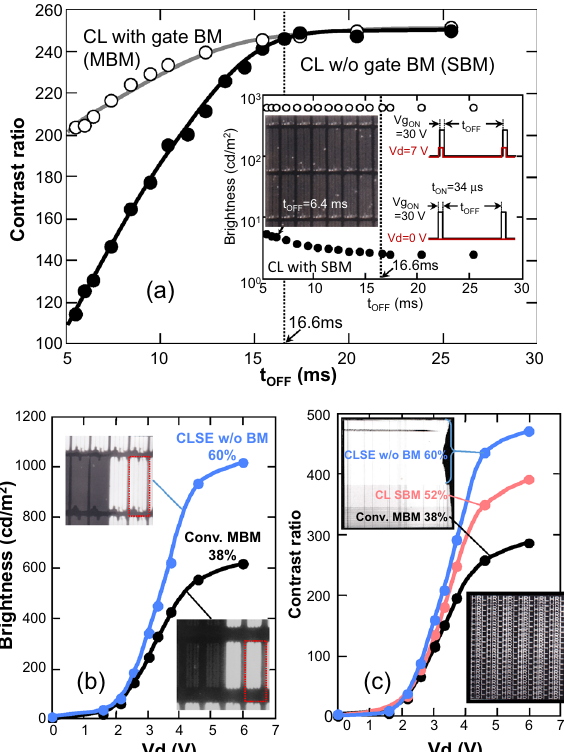
Figure 5. ( a ) Contrast ratio (CR) for CL panels with matrix BM (MBM) and stripe BM (SBM) plotted as a function of t OFF . The inset shows the brightness in the bright (Vd = 7 V) and dark (Vd = 0 V) states of the CL panel with the SBM as a function of t OFF and an optical image of the panel with t OFF = 6.4 ms. Vd (= V LC ) dependence of ( b ) brightness and ( c ) contrast ratio of the CLSE panel. Insets of ( b ): optical images indicating the elimination of the BM from the CLSE structure (upper left) and the MBM in the conventional structure (lower right). Insets of ( c ): CLSE panel composed of different areas with three different pixel structures and aperture ratios (ARs), i.e., CLSE structure without BM (60%), CL structure with SBM (52%), and conventional structure with MBM